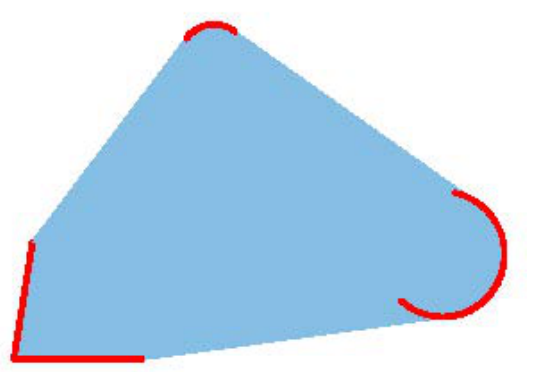
Figure 34: The convex hull of the the red set is the blue convex.